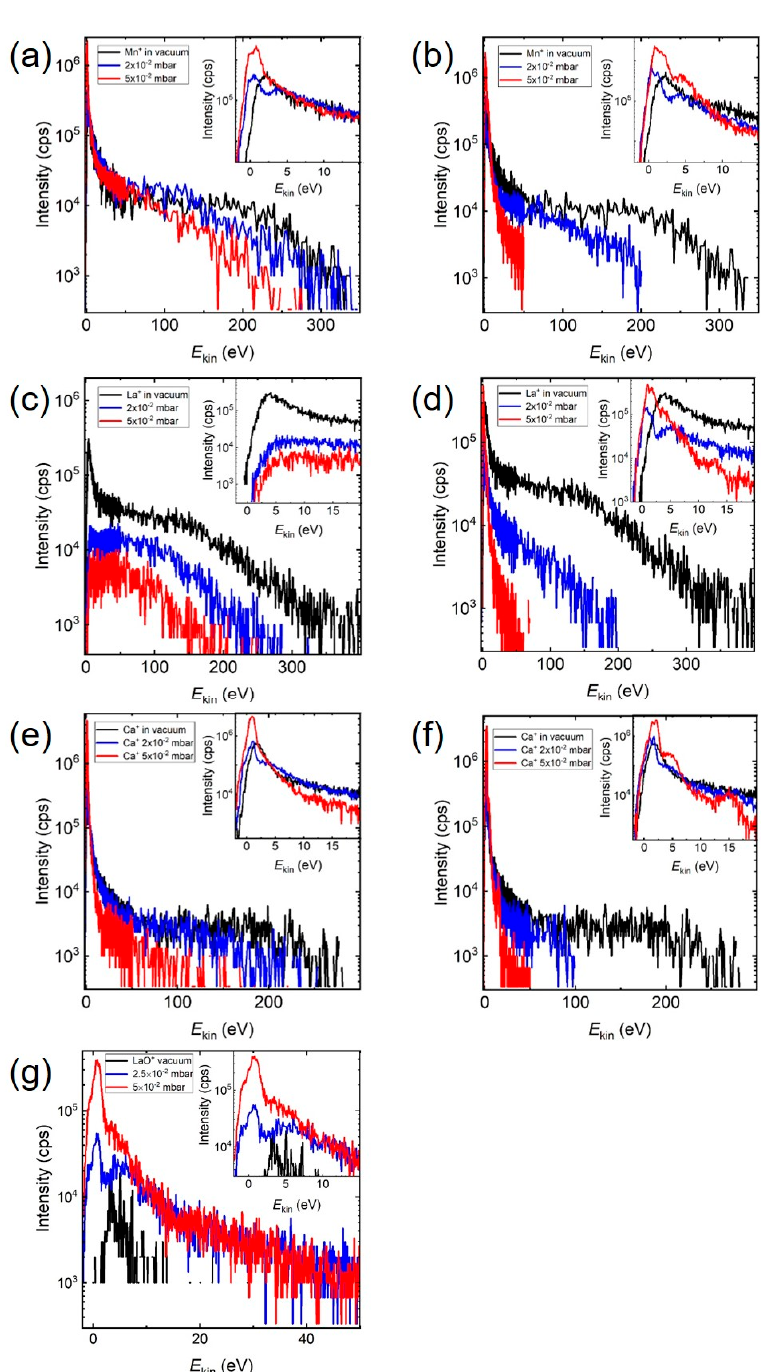
Figure 3. The ion energy distributions for ( a ) Mn + in O 2 , ( b ) Mn + in Ar, ( c ) La + in O 2 , ( d ) La + in Ar, ( e ) Ca + in O 2 , ( f ) Ca + in Ar, and ( g ) LaO + in O 2 , at three selected deposition pressures. The insets show the energy range between 0 and max. 20 eV for the ion energy distribution at different deposition pressures.